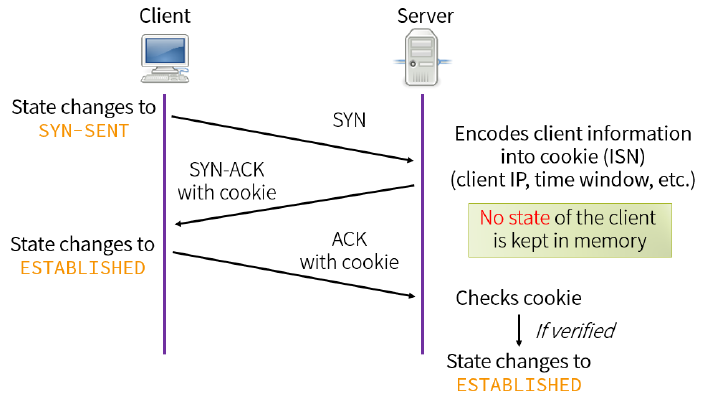
Figure 5. Illustration of TCP Cookies.